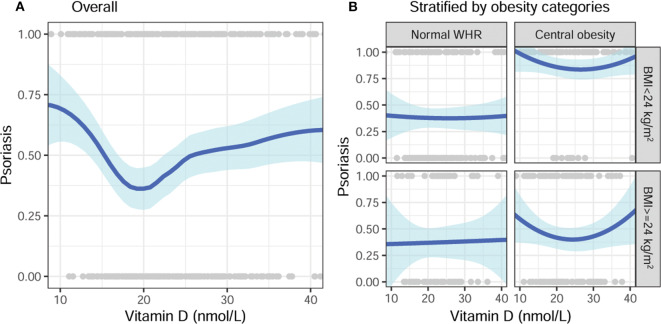
Unadjusted association of vitamin D with psoriasis, stratified by obesity categories. (A) Overall and (B) stratified by BMI and WHR categories. BMI, body mass index; WHR, waist-hip ratio.